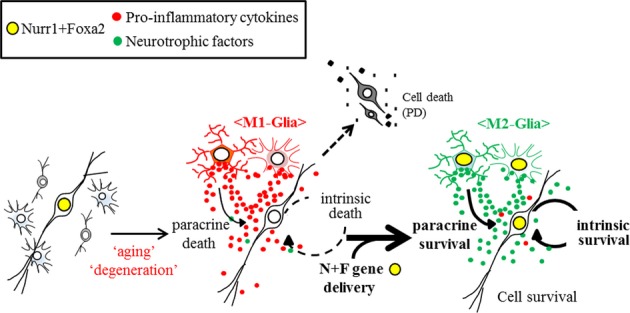
Schematic representation of mDA neuron survival promoted by forced Nurr1 + Foxa2 gene deliveryNurr1 and Foxa2 are endogenously expressed in mDA neurons and promote cell survival in a cell-autonomous manner (left). Expression of Nurr1 and Foxa2 is reduced in mDA neurons during aging and degenerative processes. In addition, glia come to be polarized toward the harmful M1-type. DA neurons with reduced Nurr1/Foxa2 expression are more vulnerable to the toxic environment in the aged or degenerating midbrain (middle). Forced expression of Nurr1 + Foxa2 in mDA neurons promotes their survival. In addition, Nurr1 + Foxa2 transgene expression in glial cells (M2-type) creates a neuroprotective environment by suppressing the secretion of pro-inflammatory cytokines as well as promoting neurotrophic factor release (right).